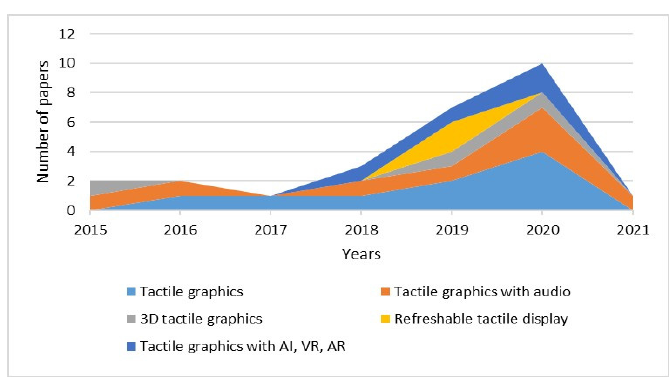
Figure 5. Selected papers for review by technology and